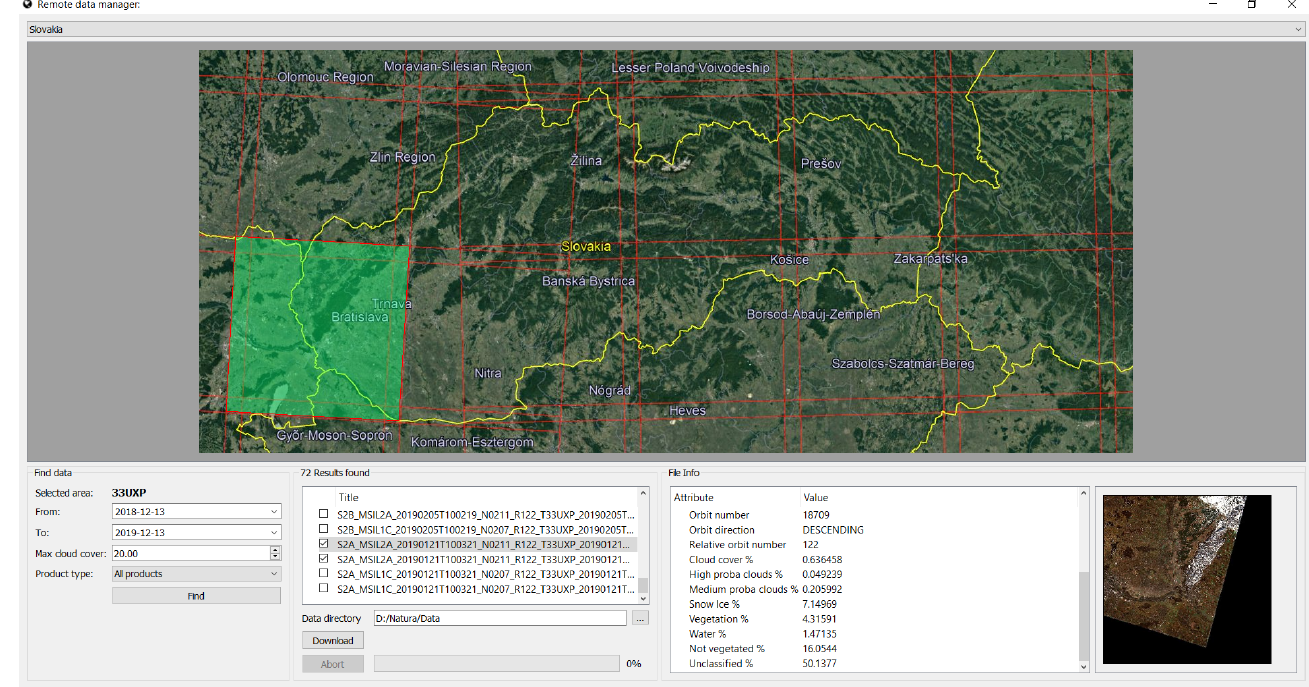
Figure 2. User interface of the remote download module containing requested files with detailed information and pre- view